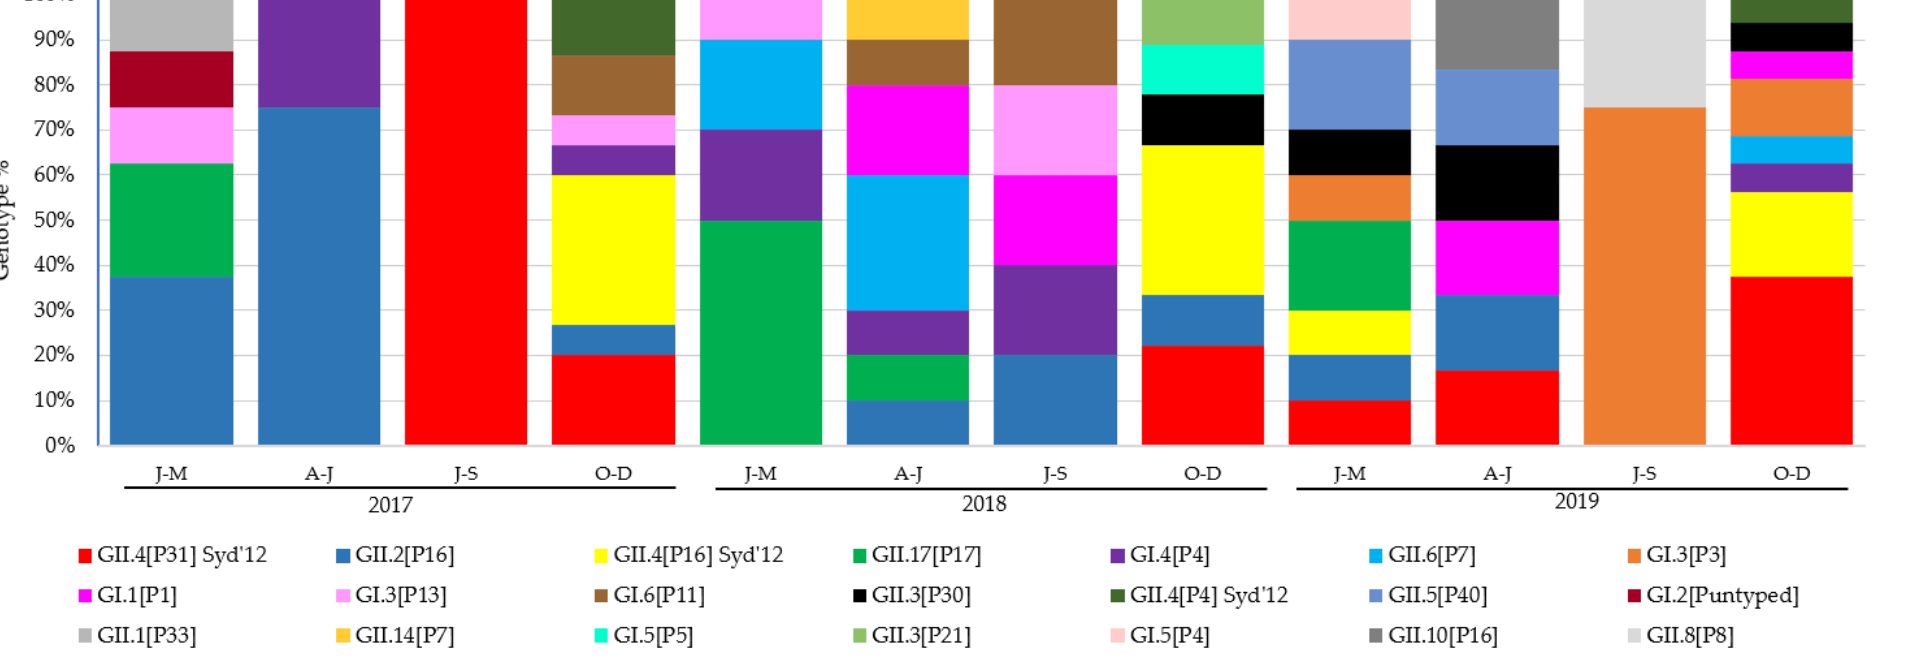
Figure 2. Distribution of genotypes identified per month of 93 typed outbreaks reported during 2017–2019. No outbreaks reported in January, July and August in